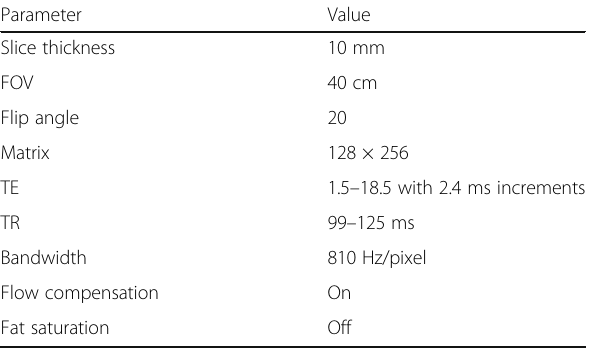
Table 1 Parameters for cardiac T2* imaging Parameter